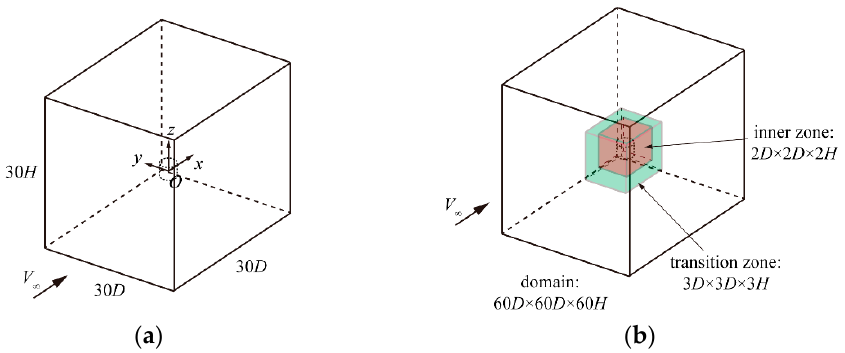
Figure 3. ( a ) Computational domain and ( b ) three mesh zones of the domain (not to scale).